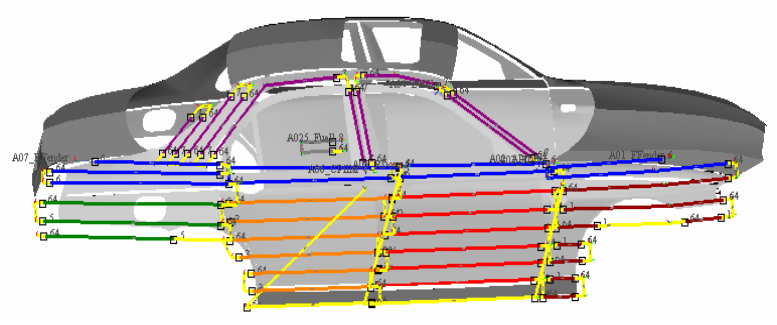
Figure 15. Spray Painting trajectory on the left part of the automobile.